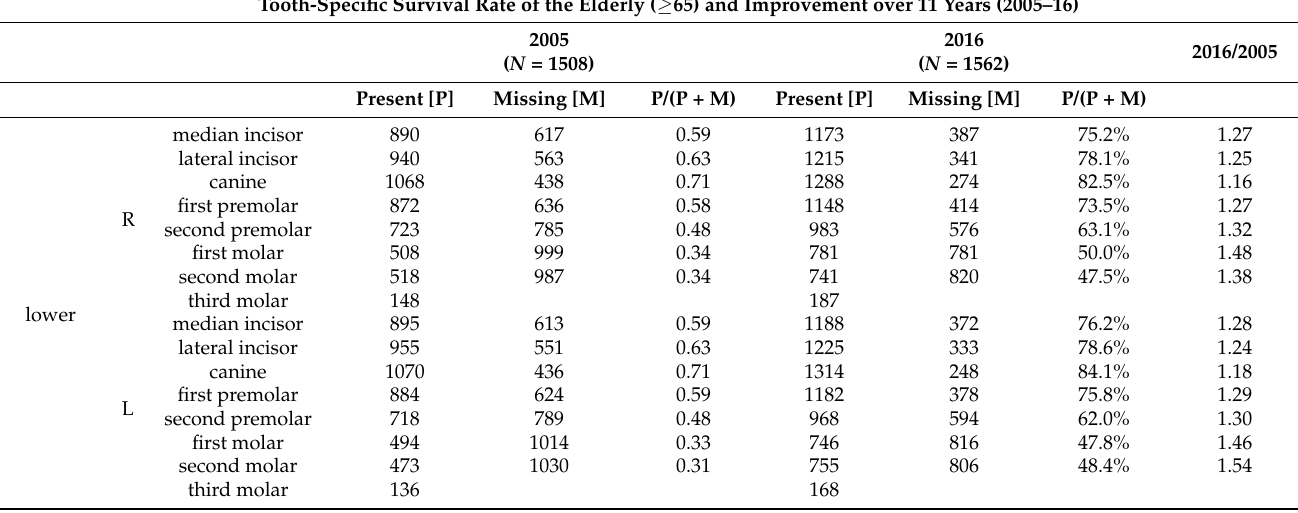
Table 3. Tooth-specific survival rate of the elderly and improvement over 11 years (2005–16). Tooth-Specific Survival Rate of the Elderly ( ≥ 65) and Improvement over 11 Years